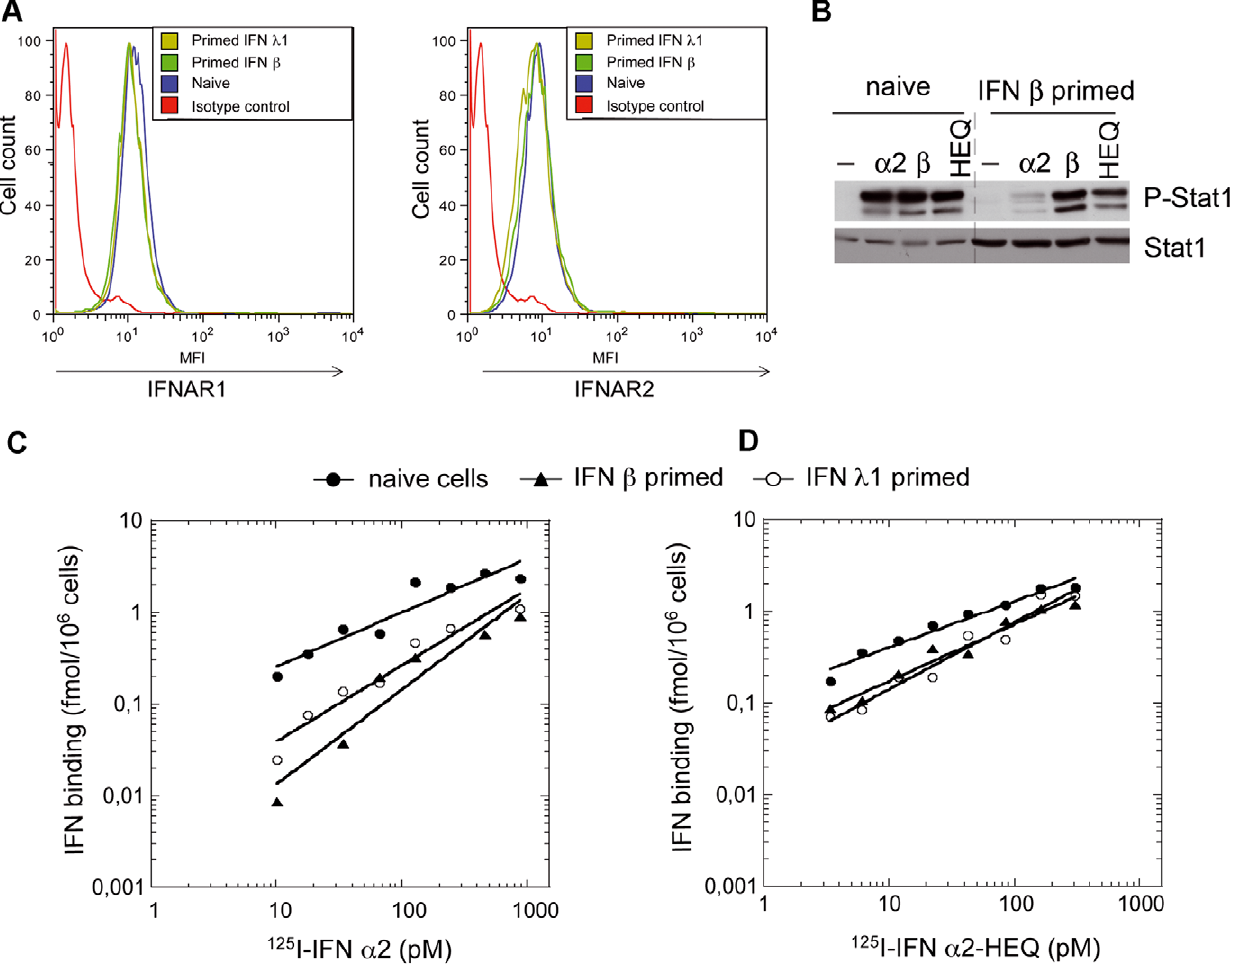
Figure 4. Analysis of the type I IFN receptor in naı ¨ ve and primed HLLR1-1.4 cells. (A) Surface level of IFNAR1 and IFNAR2 in naı¨ve cells and in IFN b or IFN l 1-primed cells as determined by FACS. Cells were primed for 24 hr, washed and maintained in medium without IFN for 24 hr. Cells were then stained with AA3 mAb (IFNAR1) or CD118 mAb (IFNAR2) followed by biotinylated rat anti-mouse Ab and streptavidin-PE. (B) Level of phosphorylation of Stat1 in naı¨ve and primed cells stimulated for 30 min with 100 pM of IFN a 2, IFN b or IFN a 2-HEQ. Lysates (30 m g) were immunoblotted with the indicated antibodies. Priming was for 8 hr followed by 16 hr resting in medium without IFN. (C and D) Binding of 125 I labelled IFN a 2 (C) or IFN a 2-HEQ (D) at 37 u C for 1 hr to naı¨ve (closed circles), IFN b -primed cells (triangles) or IFN l 1-primed cells (open circles). Cells were primed for 8 hr and maintained without IFN for 16 hr.